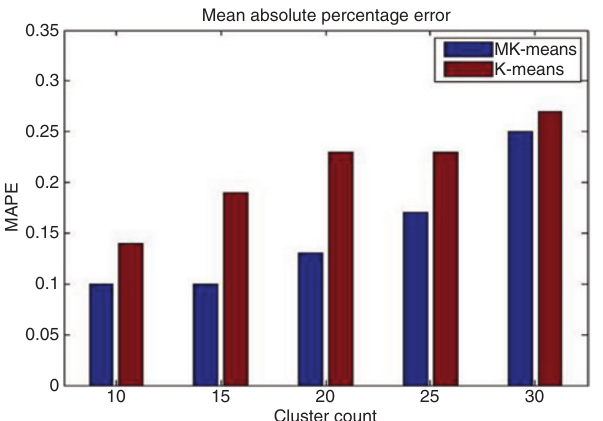
Figure 5: Performance Comparison of MAPE Plots by Varying Cluster Counts.